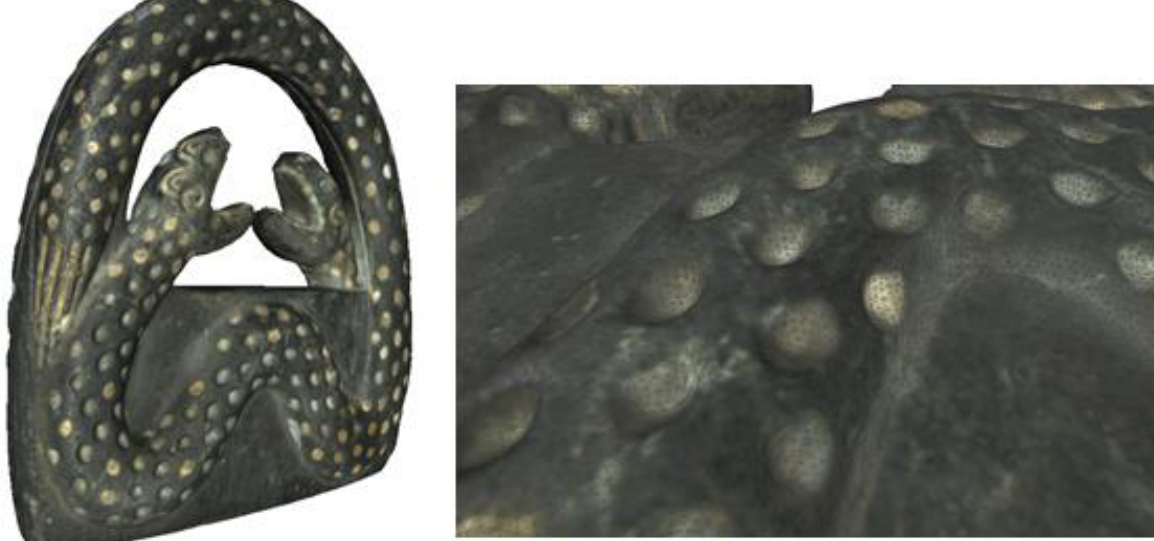
Figure 7. 3D base model of the “Snake” figure: overview (on the left ) and mesh visible (on the right ).